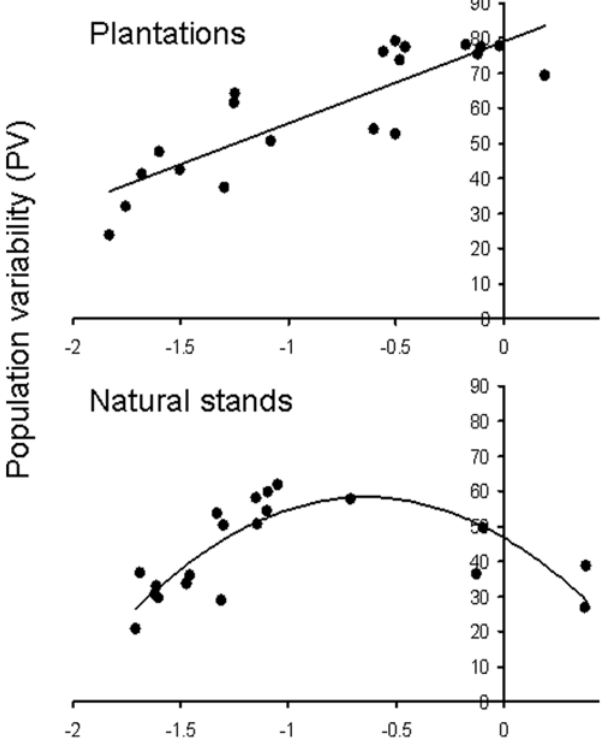
Figure 2. Regression models between population variability and mean density of P. vulgatissima . Models are fitted to the relationships between population variability (PV) and mean density in willow plantations (upper figure) and natural willow stands (lower figure).